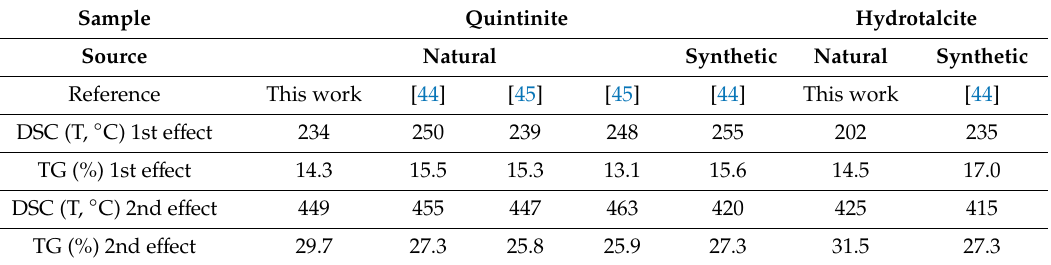
Table 3. Comparison of TG and DSC data for quintinite and hydrotalcite from di ff erent sources. Sample Quintinite